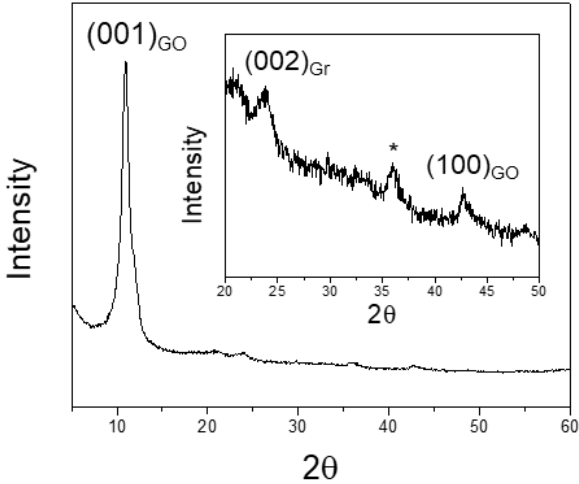
Figure 3. X-Ray powder diffraction (XRPD) pattern of graphene oxide (GO). Numbers into brackets in correspondence to Bragg peaks are the Miller indexes of reflections based on graphite hexagonal cell. GO and Gr subscripts refer to graphene oxide and graphite, respectively. The inset highlights the high 2θ range.